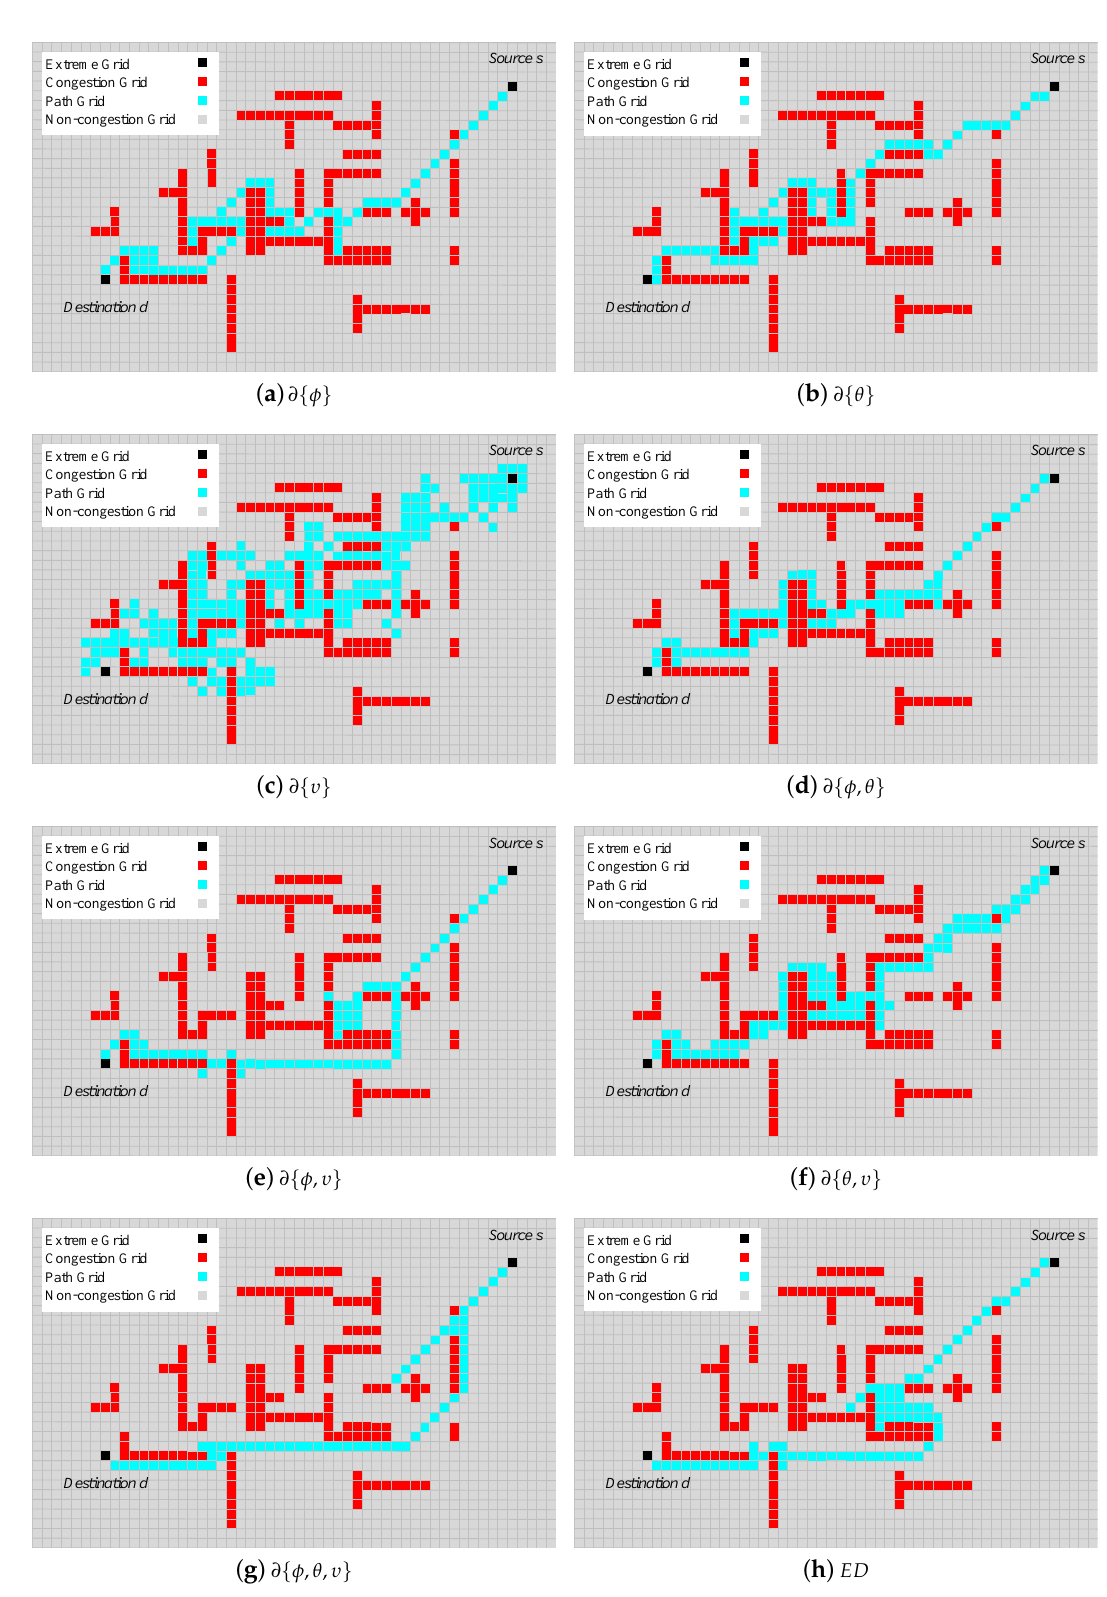
Figure 15. The effect of different parameters on the path planning algorithm is tested for the parameters that make up the quaternion function. ( a ) Impact of ∂ { φ } on path planning. ( b ) Impact of ∂ { θ } on path planning. ( c ) Impact of ∂ { υ } on path planning. ( d ) Impact of ∂ { φ , θ } on path planning. ( e ) Impact of ∂ { φ , υ } on path planning. ( f ) Impact of ∂ { θ , υ } on path planning. ( g ) Impact of ∂ { φ , θ , υ } on path planning. ( h ) Only according to Euclidean Distance for path